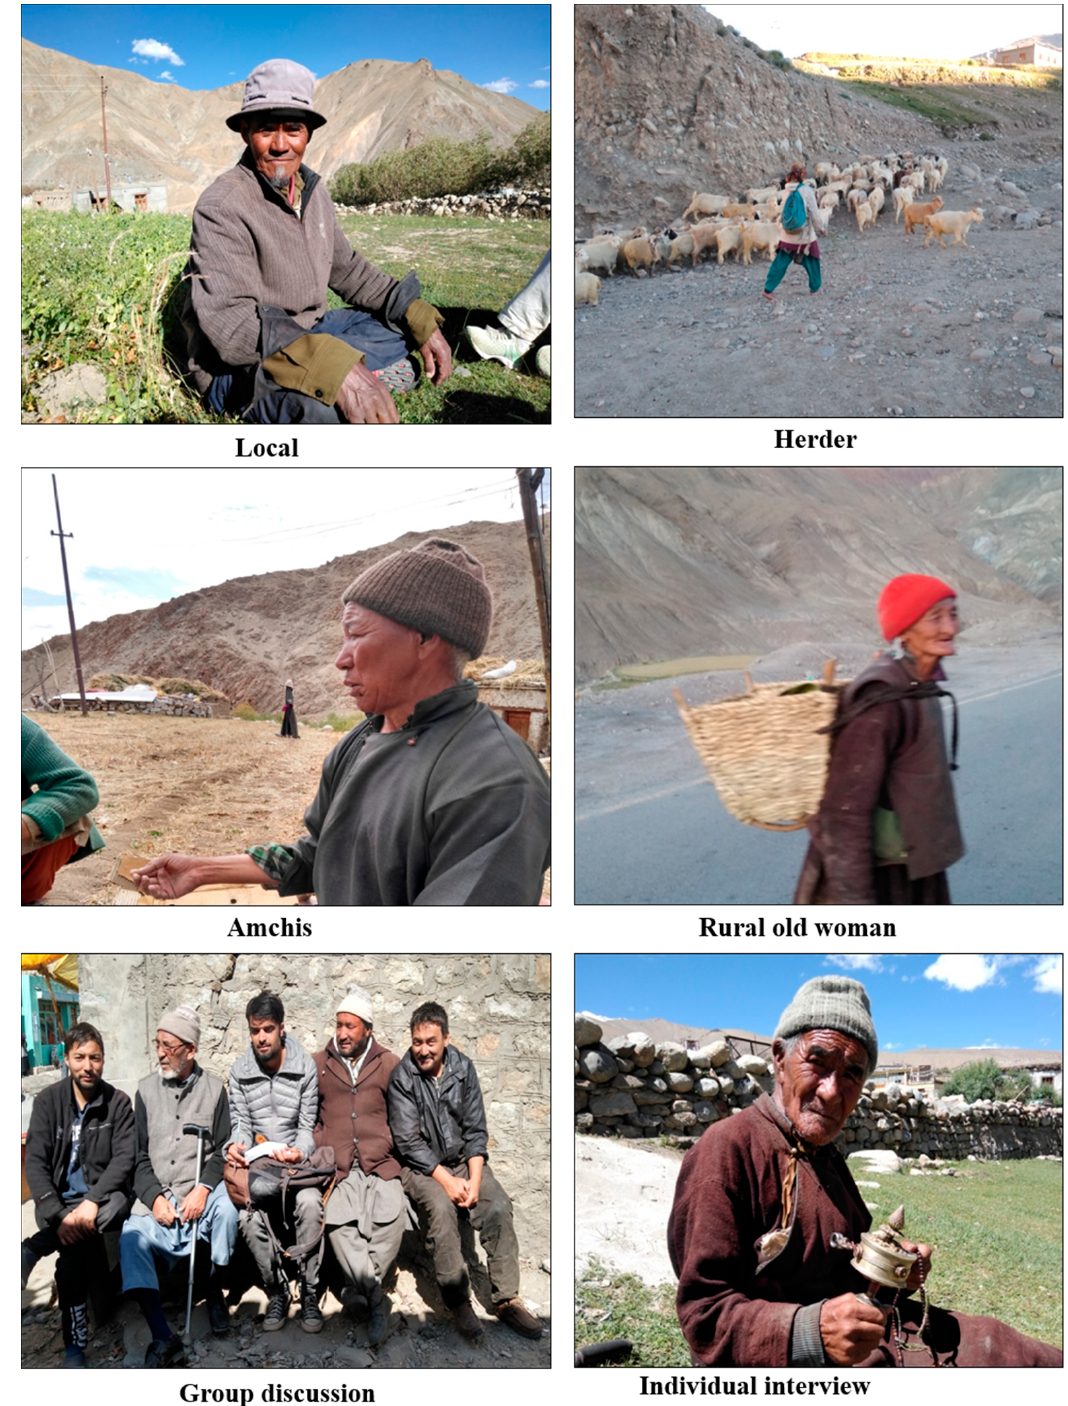
Figure 2. Diverse ethnic groups of the study area.